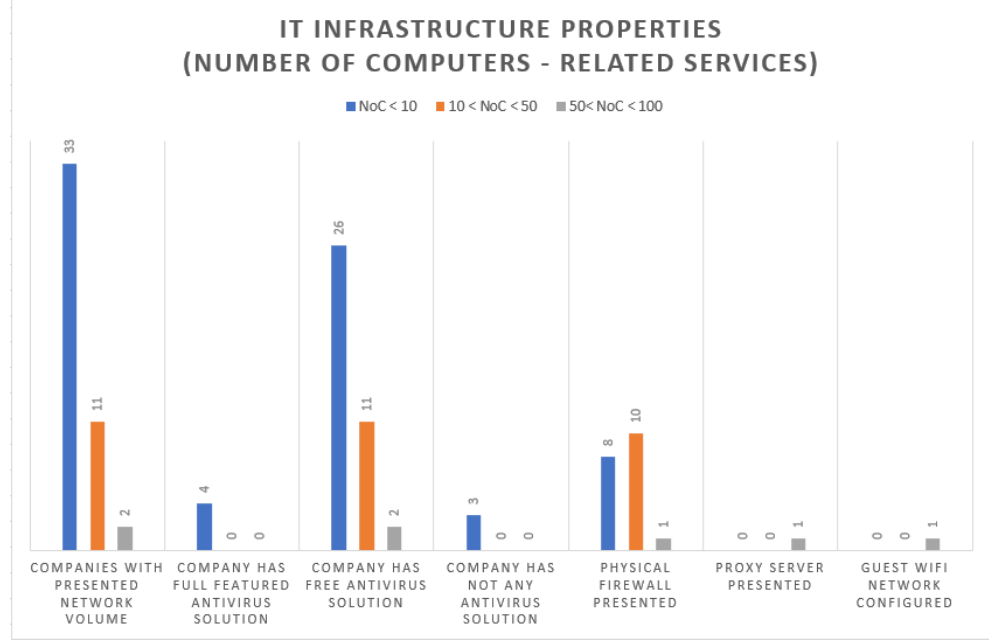
Figure 4. IT infrastructure properties for examined